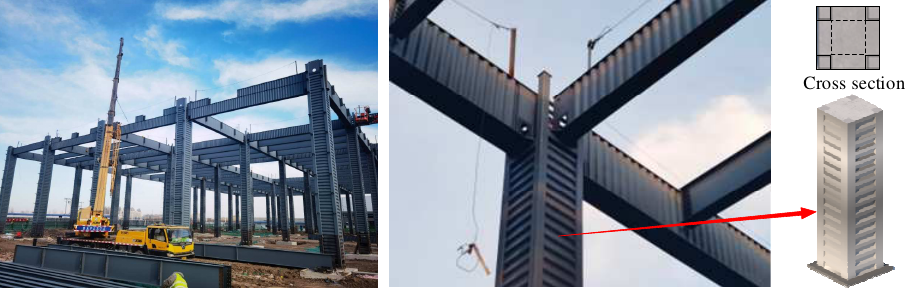
Figure 1. Application of S-CSC column